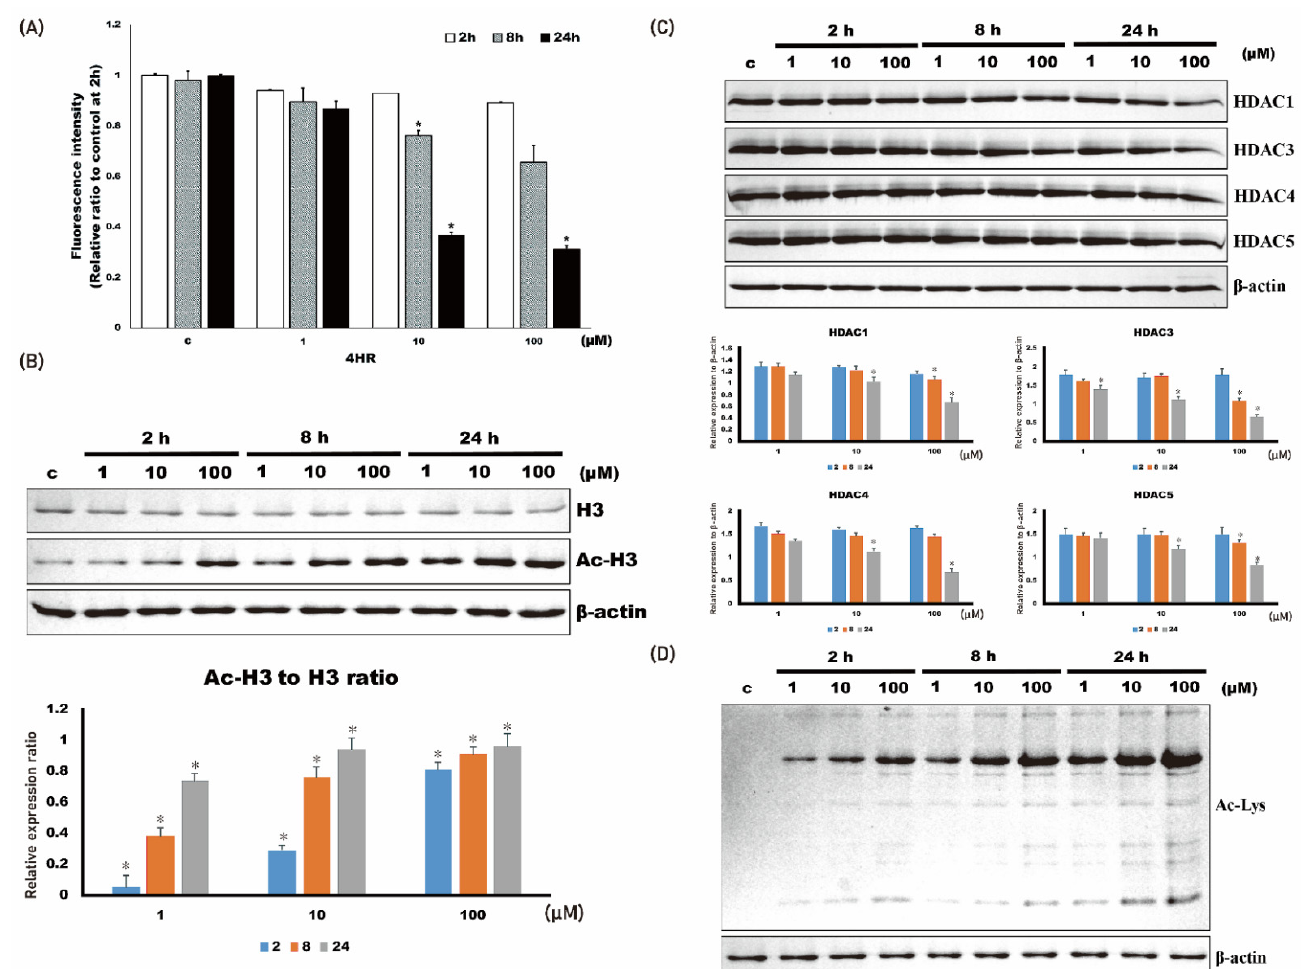
Figure 1. 4HR administration and histone deacetylase activity in Saos-2 cells. The administration of 4HR decreased histone deacetylase activity and the expression level of HDAC1, 3, 4, and 5. ( A ) Histone deacetylase activity decreased upon 4HR administration. When compared to untreated control, 10 and 100 μ M 4HR group showed significantly lower values at 8 and 24 h after administration (* p < 0.05). ( B ) The level of acetylated histone 3 (Ac-H3) increased by 4HR administration. When Ac-H3 to H3 ratio of untreated control was compared, 4HR administered groups showed significantly higher values (* p < 0.05). ( C ) Expression level of HDAC1, 3, 4, and 5 decreased by 4HR administration. When compared to untreated control, 10 and 100 μ M 4HR group showed significantly lower values at 8 and 24 h after administration (* p < 0.05). ( D ) Protein acetylation level generally increased by 4HR administration, as shown in whole cellular lysates.